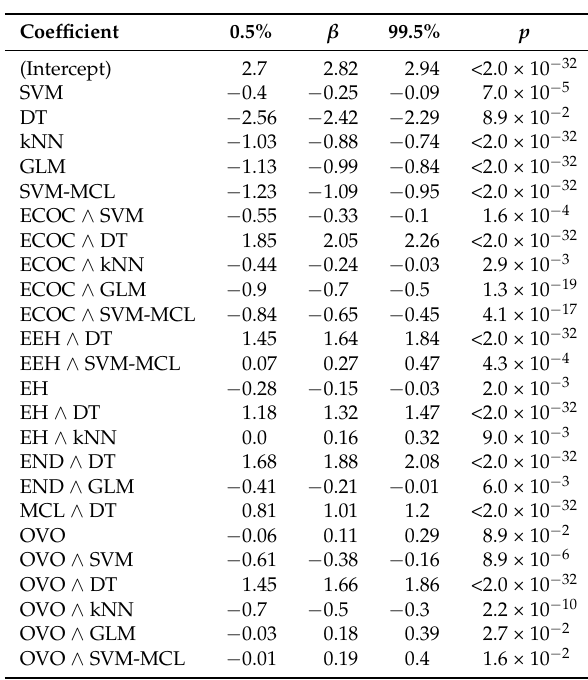
Table 7. Estimated logistic regression coefficients with p < 0.1 for the binary problem induced by the topmost dichotomy of